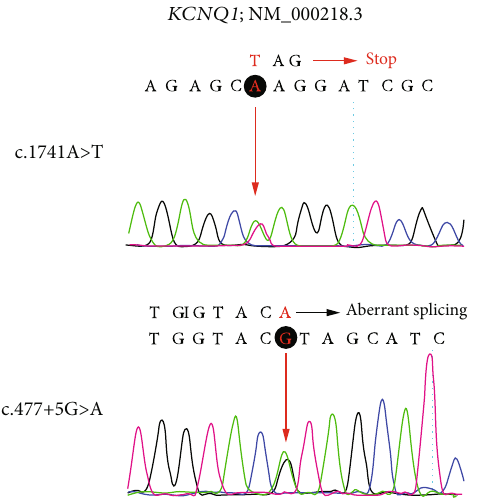
Figure 4: Mutated KCNQ1 sequences of the identi fi ed c.1741A > T (above) and c.477+5G > A (below) variant. The mutated nucleotide is shown in red. Red “ stop ” indicates termination of synthesis. I: boundary of corresponding exon and intron. Red arrows and black rounds: sites of nucleotide